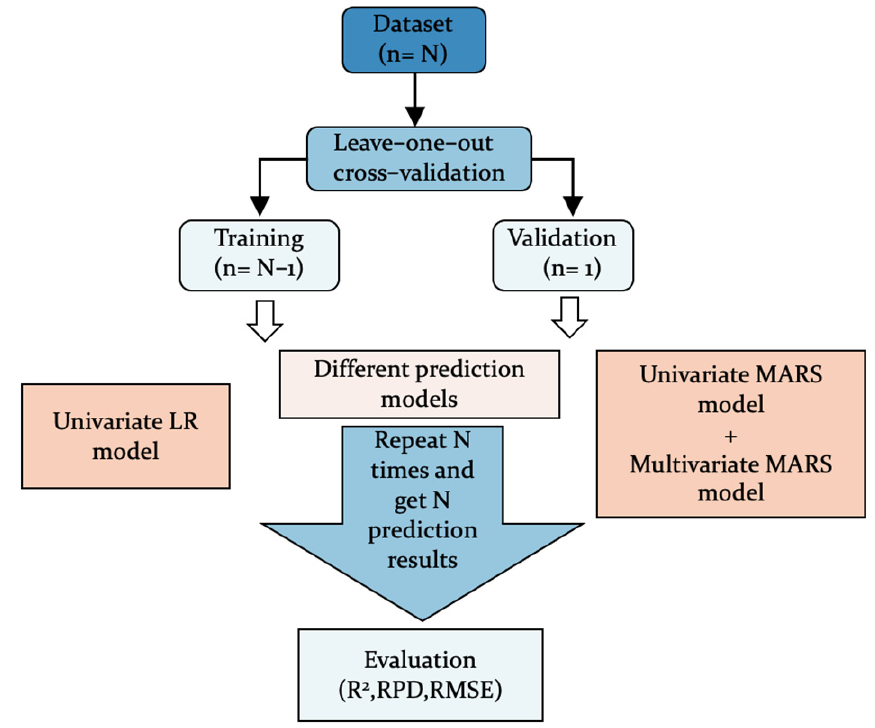
Figure 1. Flowchart of the prediction model.